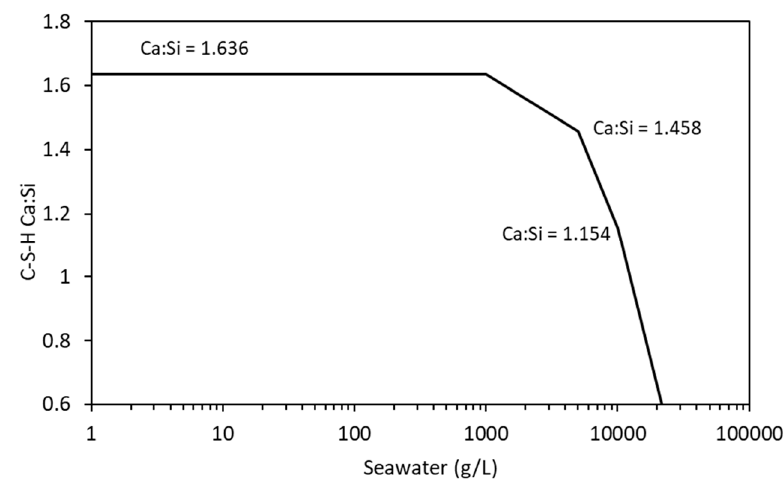
Figure 13. Change in C-S-H Ca:Si ratio with increasing seawater exposure.